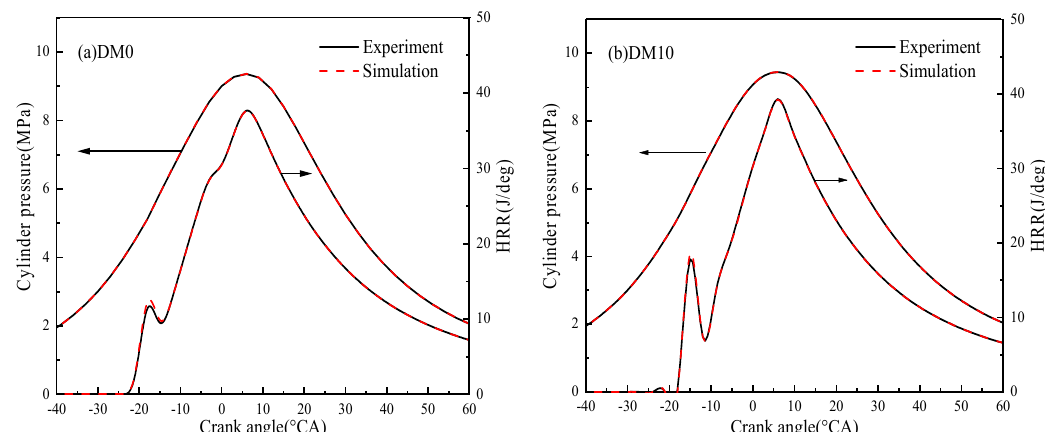
Figure 3. Comparison of cylinder pressure and HRR under different fuel mixing ratios.